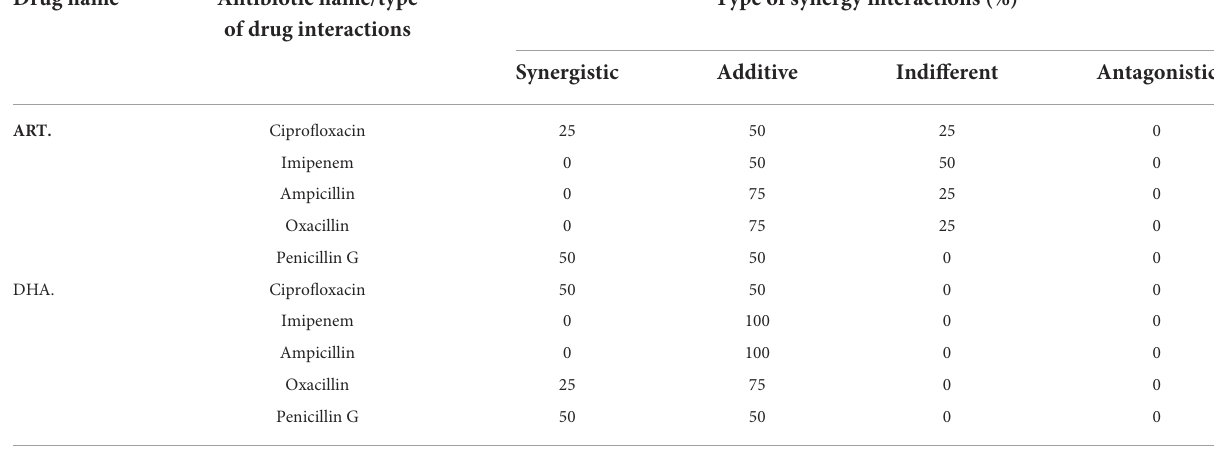
TABLE 2 Percentage of isolates with different synergy interactions of ART and DHA with antibiotics. Drug